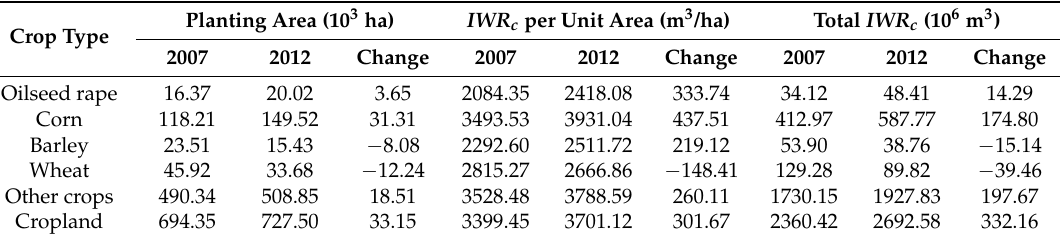
Figure 6. Maps to show the spatiotemporal distribution of crop planting within the HRB in ( a ) 2007 and ( b ) 2012. Table 2. Changes in HRB crop planting area and IWR c between 2007 and